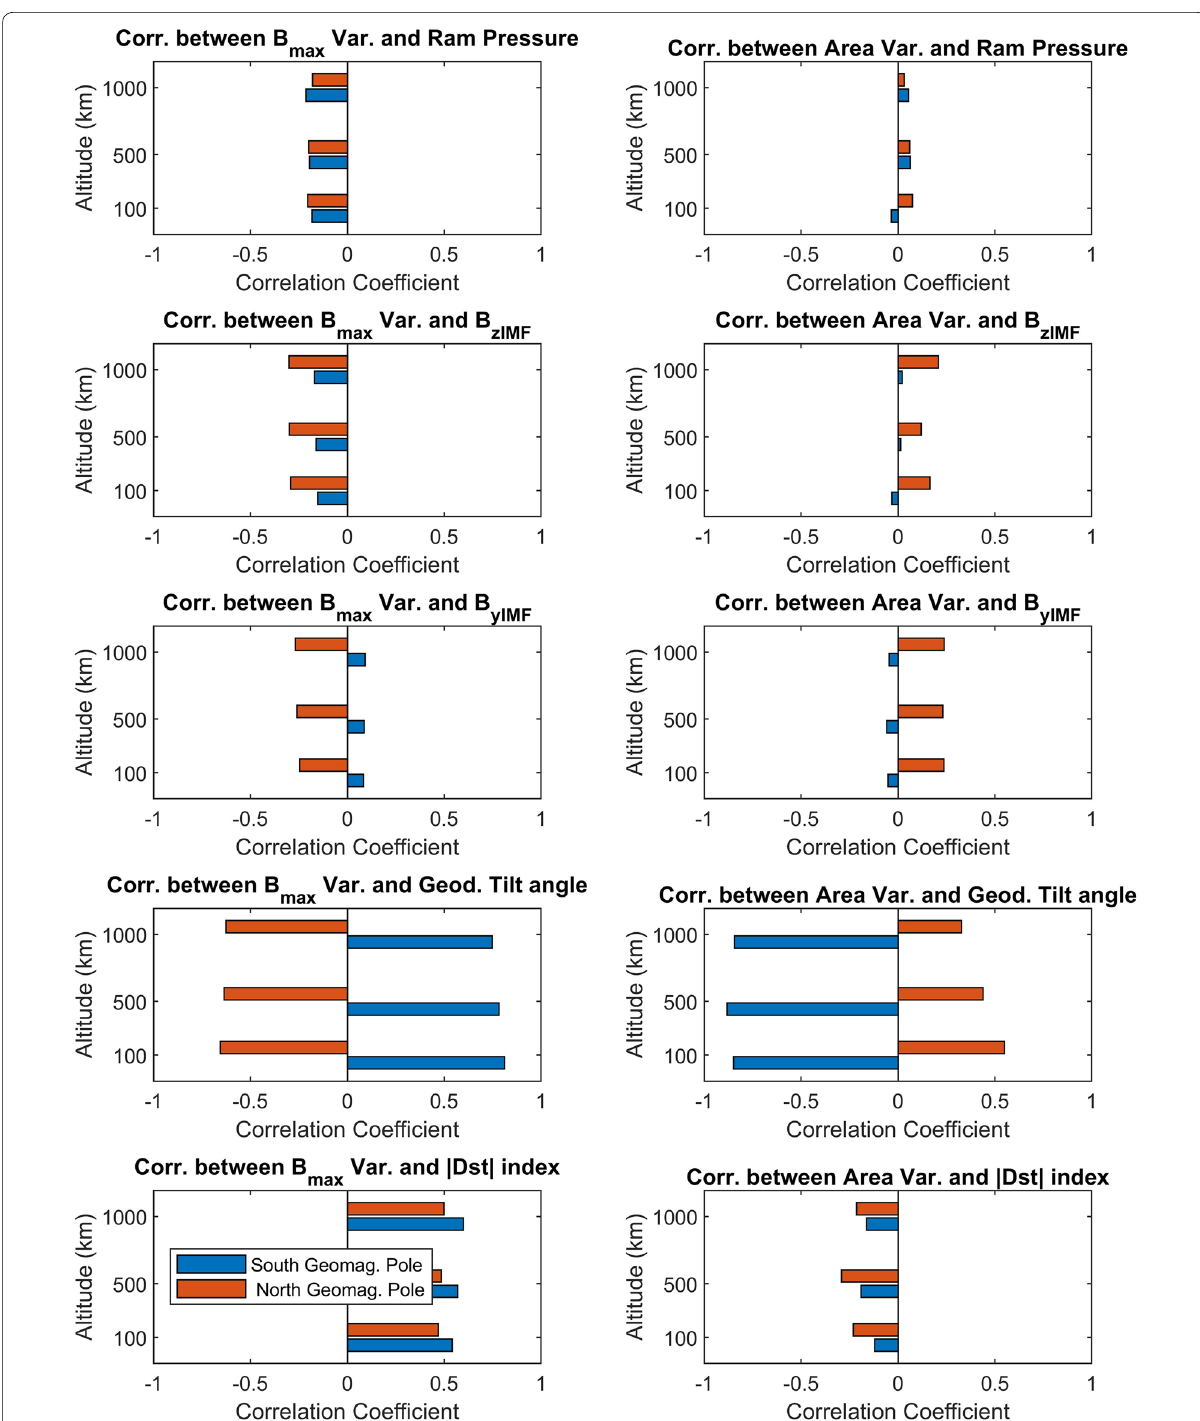
Fig. 7 Statistical study results. Correlation coefficients between the magnetic pole area and B max variations, with respect to the space weather parameters, and according to the altitudes, 100, 500, and 1000